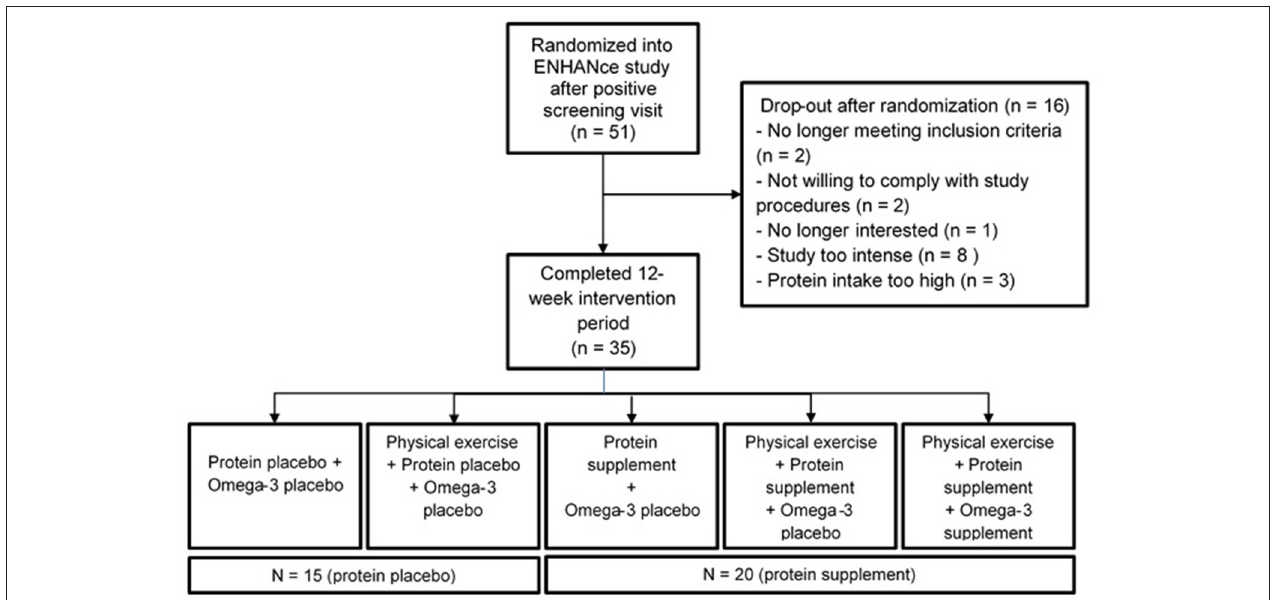
FIGURE 1 | Overview of flow of participant of the ENHANce study relevant for this article.